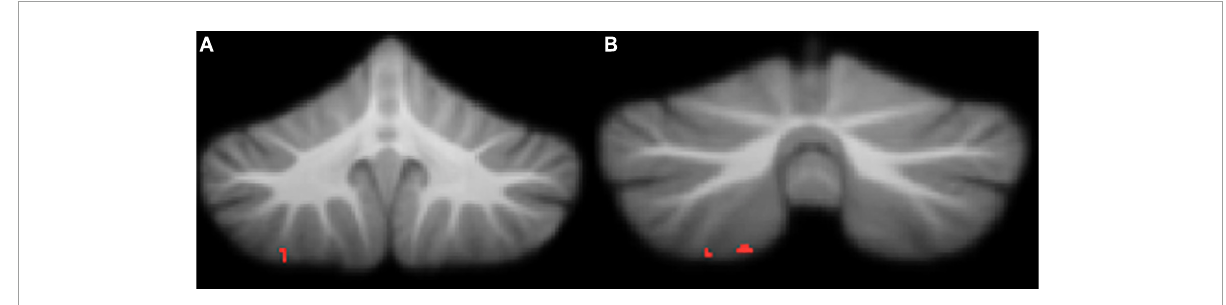
FIGURE4 Significant negative correlations between grey matter and Conners ADHD Index t -scores. (A) right lobule VIIIa; (B) right lobule VIIIa. All results reported with threshold free cluster enhancement (TFCE) correction, uncorrected across contrast at p < 0.01; cluster size threshold at 50